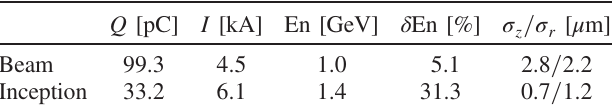
TABLE III. Injected trailing (black) and inception (red) beams charge, Q ; current, I ; Root-Mean-Square (RMS) energy of the ffiffiffiffiffiffiffiffiffiffiffiffiffiffiffiffiffiffiffiffiffiffiffiffiffiffiffiffiffiffiffiffiffiffiP over all non-centered weighted energy (i.e., beam macro-particles i ), En, and energy spread, δ En; and beam longitudinal and transverse standard deviations, σ z and σ r ; corresponding to the beams plotted in Fig. 2(b) (see [23] for more detail). Results are from the control simulation that uses the longitudinal flat-top plasma profile as shown by green line in Fig. 2(a), and are extrapolated from a total of 20% of all He released electron macroparticles in the simulation box at the end of the run (after they left the